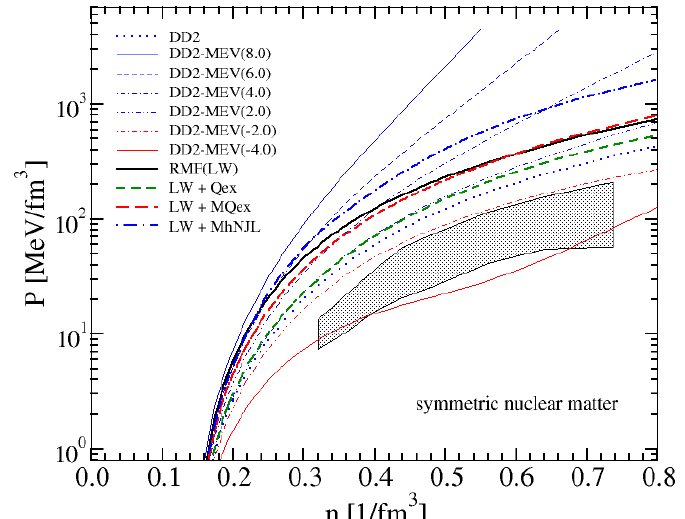
Figure 6. Same as the left panel of Figure 5 on a logarithmic pressure scale and compared to a set of EoS for the DD2 EoS with excluded volume corrections from [12]. From this comparison one could read-off a density dependent excluded volume corresponding to the quark Pauli blocking effect in the equation of state. The hatched region corresponds to the constraint derived from the analysis [26] of flow data from heavy ion collision